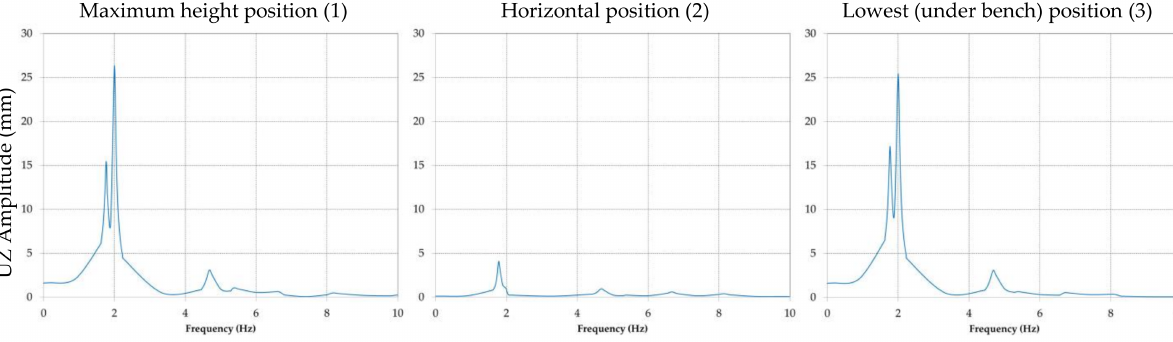
Figure 15. Comparative results of the amplitude of the displacement in direction Z for positions (1), (2) and (3) of the BWE